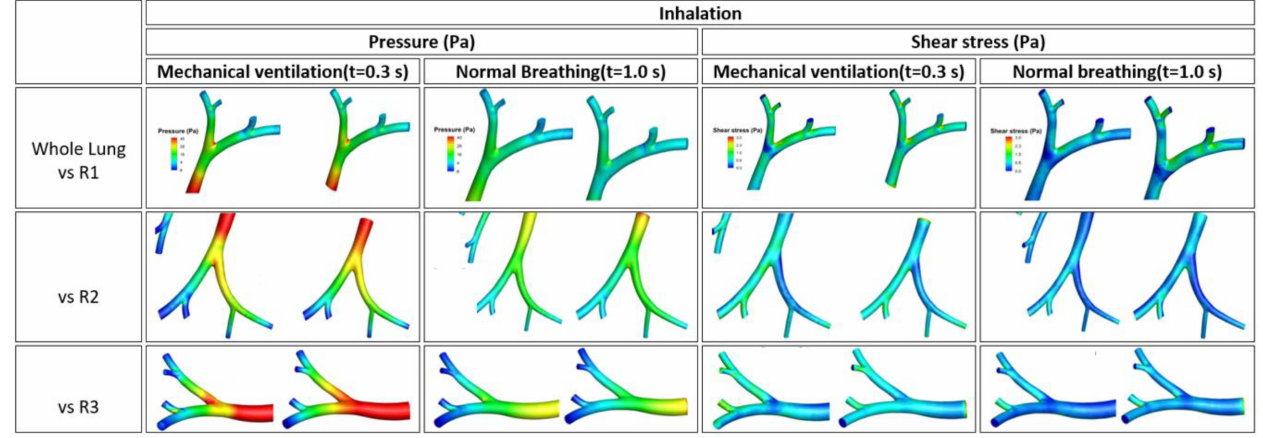
Figure 11. Comparison of pressure and shear stress for right bifurcations of whole lung and isolated local bifurcations (R1, R2, and R3). The plots are for the MV and NB during inhalation at t = 0.3 s, t = 1.0 s, respectively.